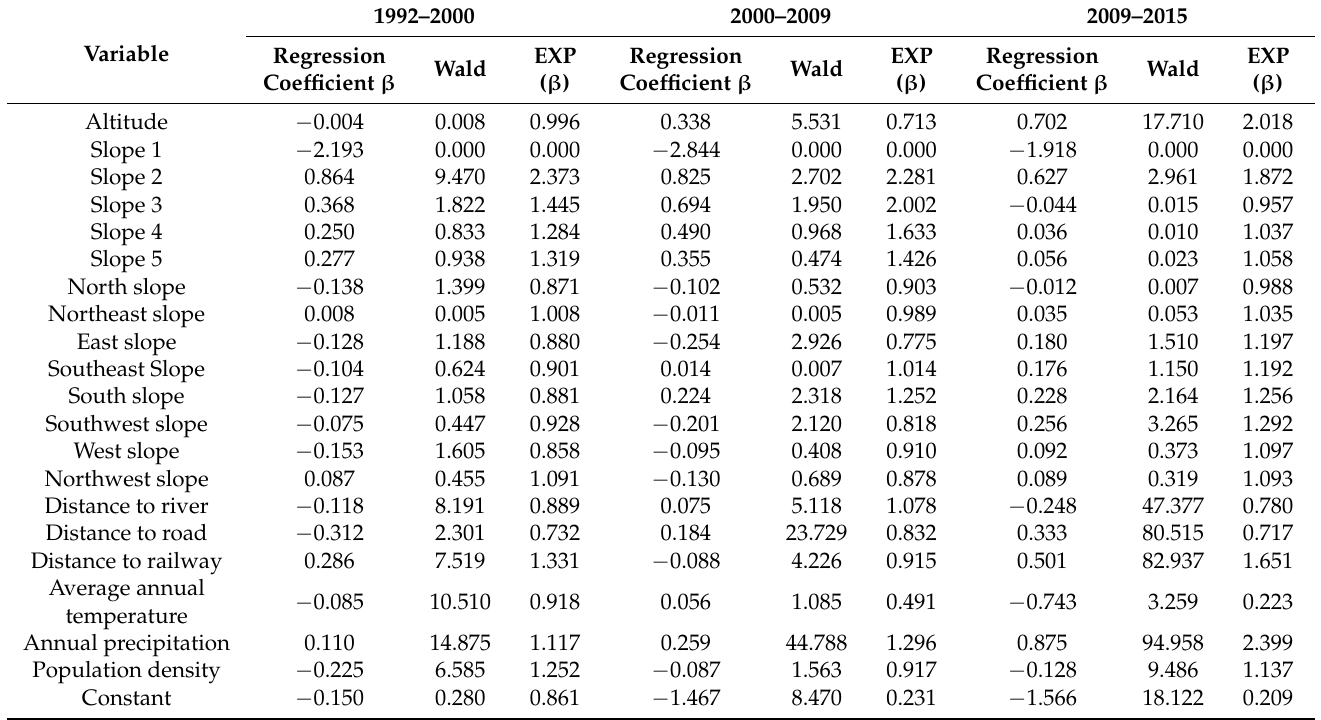
Table A3. Model estimates for Coniferous Forest land expansion driving